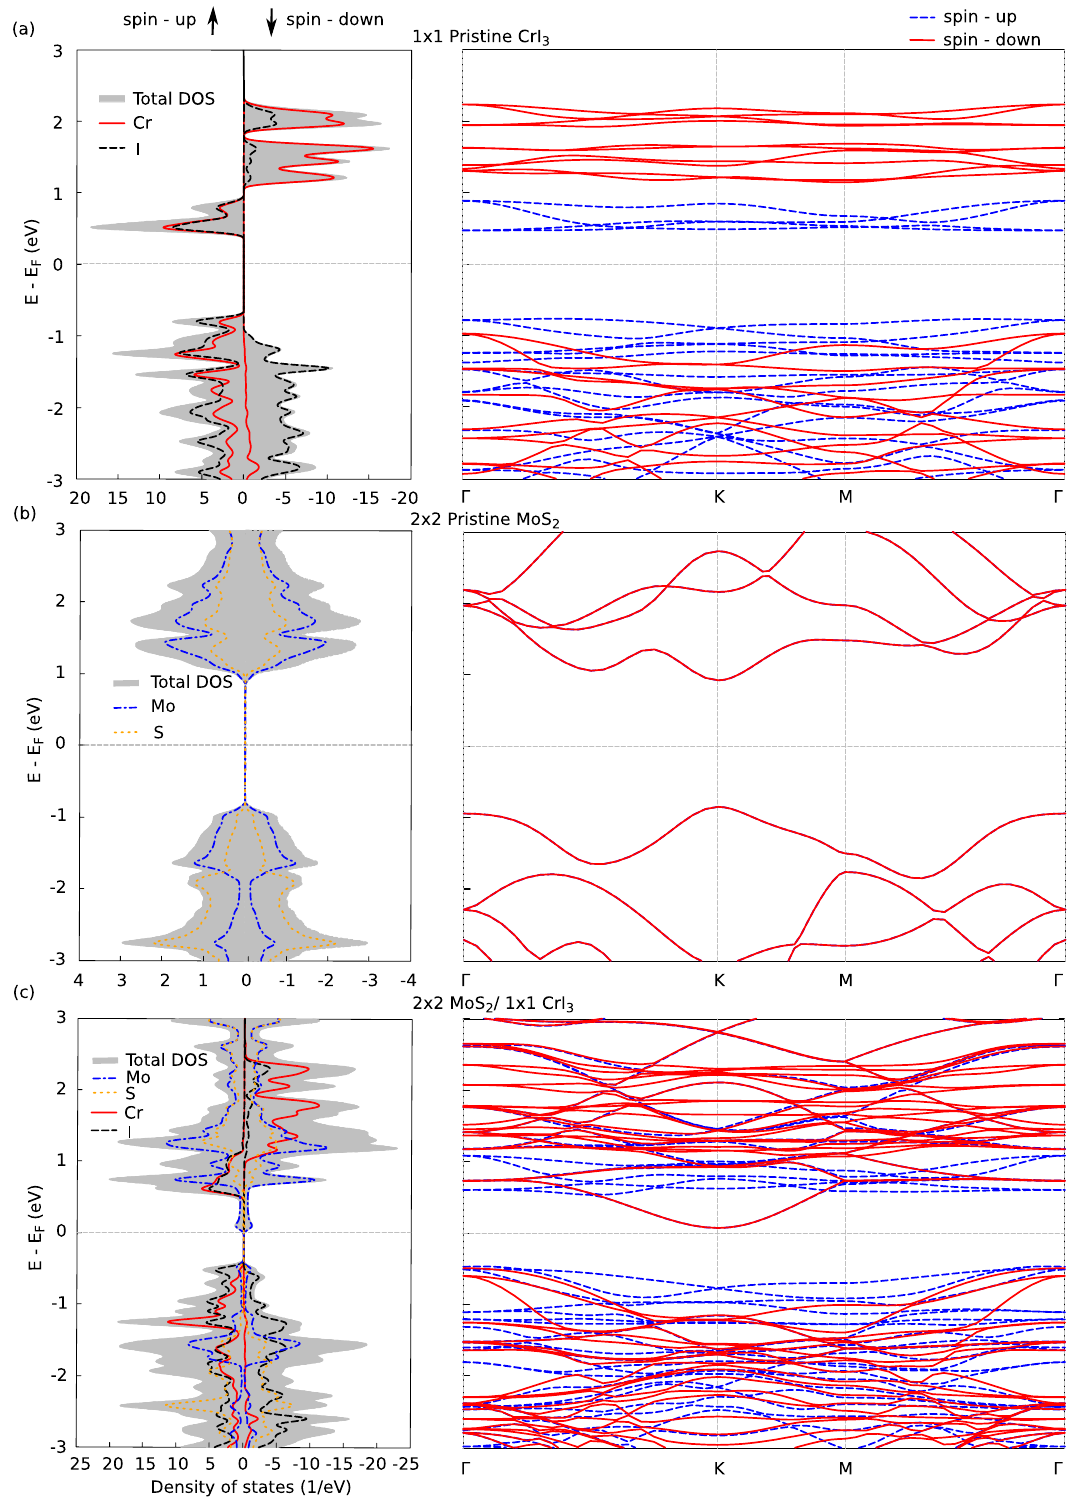
Figure 2. Spin-polarized projected density of states (DOS) and bandstructure for ( a ) pristine monolayer of 1 × 1 CrI 3 ( b ) pristine (unstrained) monolayer of 2 × 2 MoS 2 ( c ) 2:1 MS/CrI 3 (Hollow configuration) with 2 × 2 MoS 2 adsorbed on 1 × 1 CrI 3 . Gaussian smearing of 0.004 eV has been used to visualize the